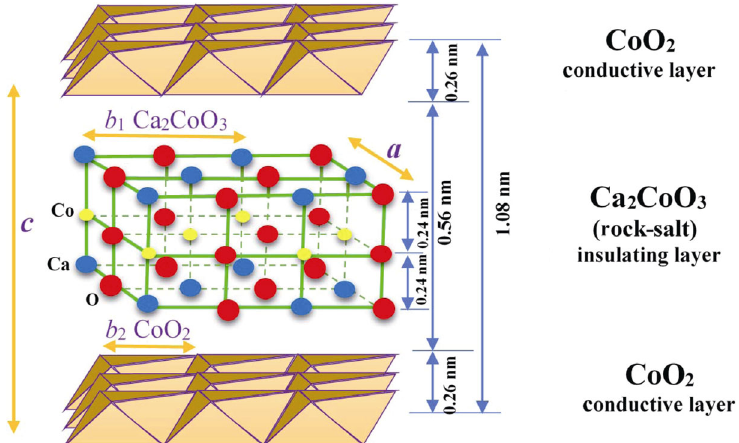
Fig. 1 Crystal structure of Ca 3 Co 4 O 9 [12–14]. Reproduced with permission from Ref. [12], © Elsevier Ltd and Techna Group S.r.l. 2018; Ref. [13], © The Royal Society of Chemistry. 2016; and Ref. [14], © American Chemical Society.